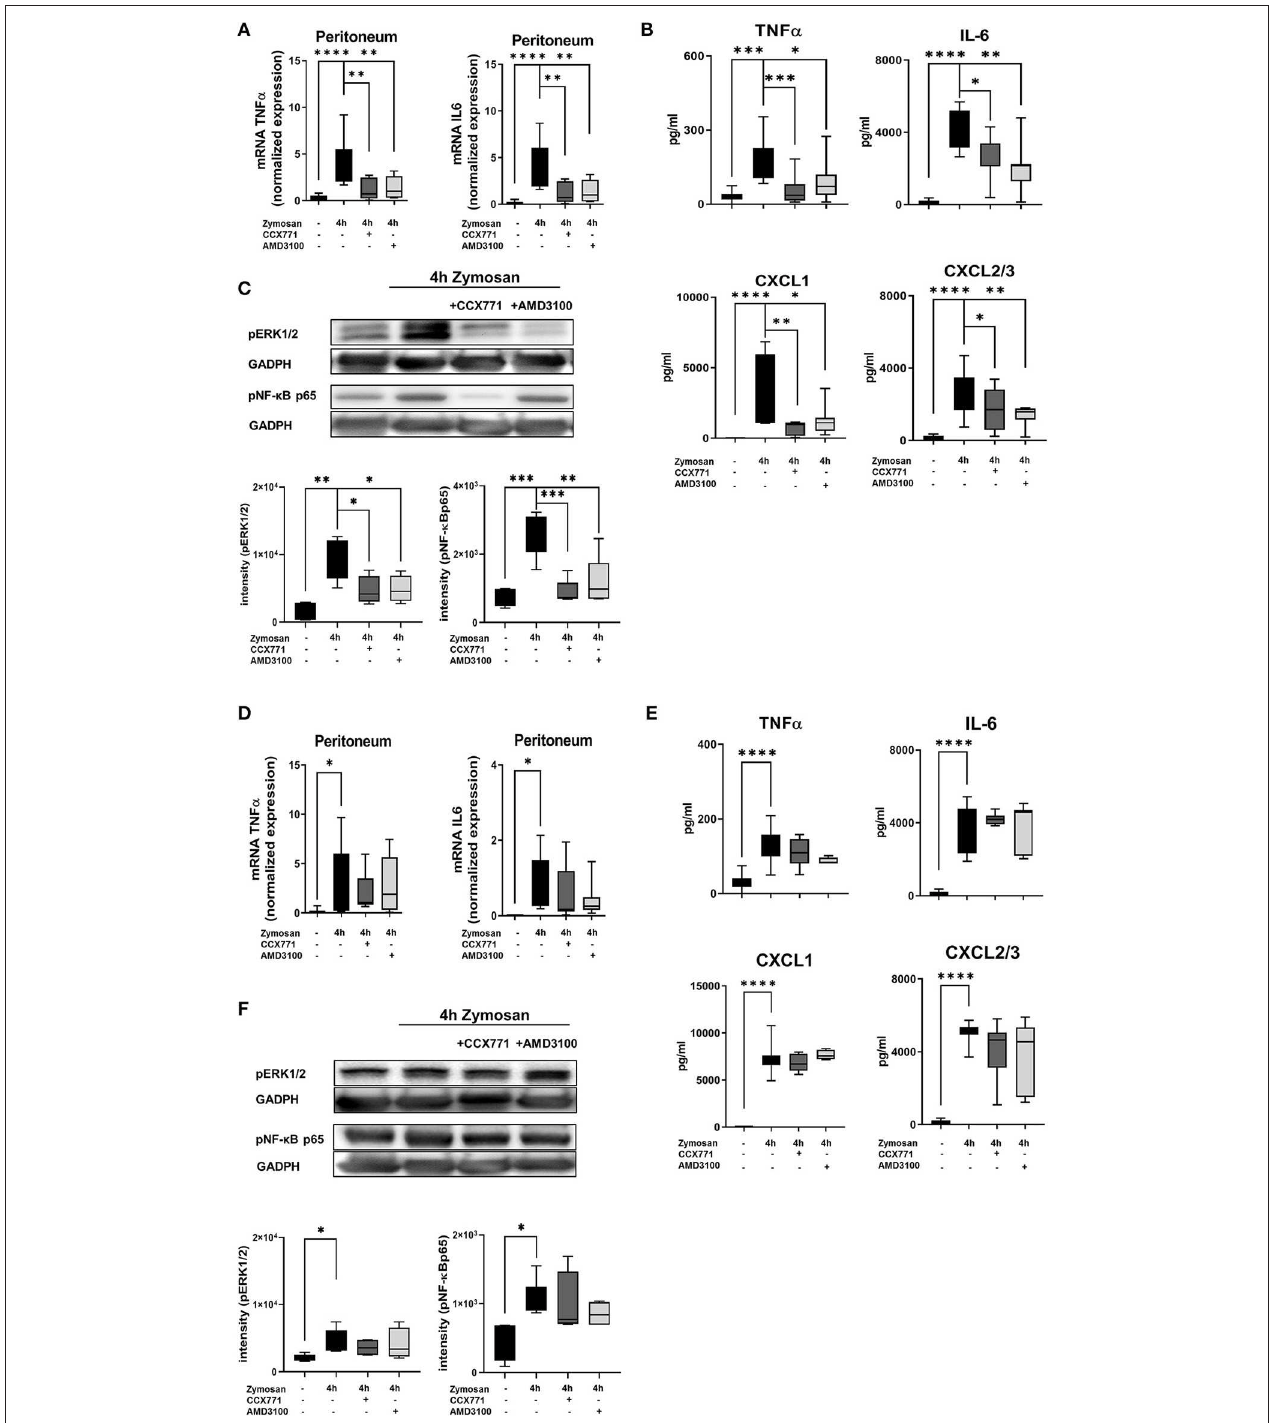
FIGURE 5 | Impact of the SDF-1 receptors CXCR4 and CXCR7 on the release of inflammatory cytokines and intracellular pathways. (A) After the induction of peritonitis by zymosan, effects of AMD3100 or CCX771 on the gene expression of TNF α and IL6 were evaluated in peritoneal tissue of wild type and (D) A 2B –/– mice. (B) The release of inflammatory cytokines (TNF α and IL6) and chemokines (CXCL1 and CXCL2/3) in the peritoneal cavity of wild type and (E) A 2B –/– animals was detected. (C) Effects of CXCR4 and CXCR7 inhibition on the phosphorylation of intracellular ERK1/2 and NF- κ B subunit 65 in peritoneal tissue of wild type and (F) A 2B –/– animals 4h after NaCl or zymosan with or without AMD3100- or CCX771 were determined. Blots are representatives of n = 3 experiments. Intensity of the blots was evaluated by ImageJ. For statistical analysis, one-way ANOVA was used with Bonferroni post-hoc test. Data are presented as box and whisker graph with error bars indicating the range from minimum to maximum value; n = 6–12; * p < 0.05; ** p < 0.01; *** p < 0.001, and **** p < 0.0001.